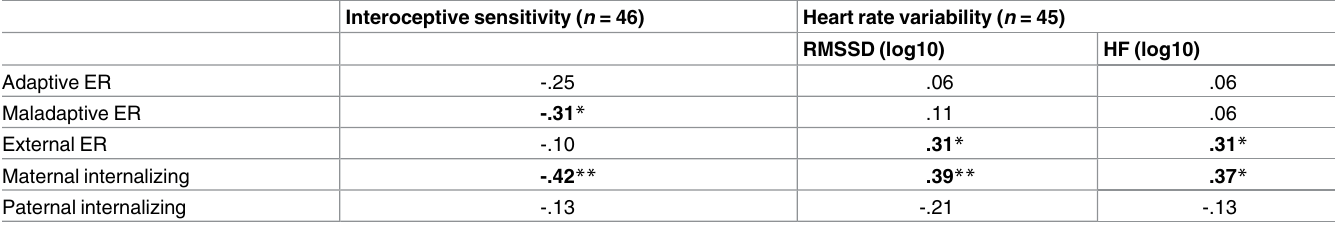
Table 2. Partial correlations between interoceptive sensitivity and heart rate variability and ER strategies and parental internalizing.